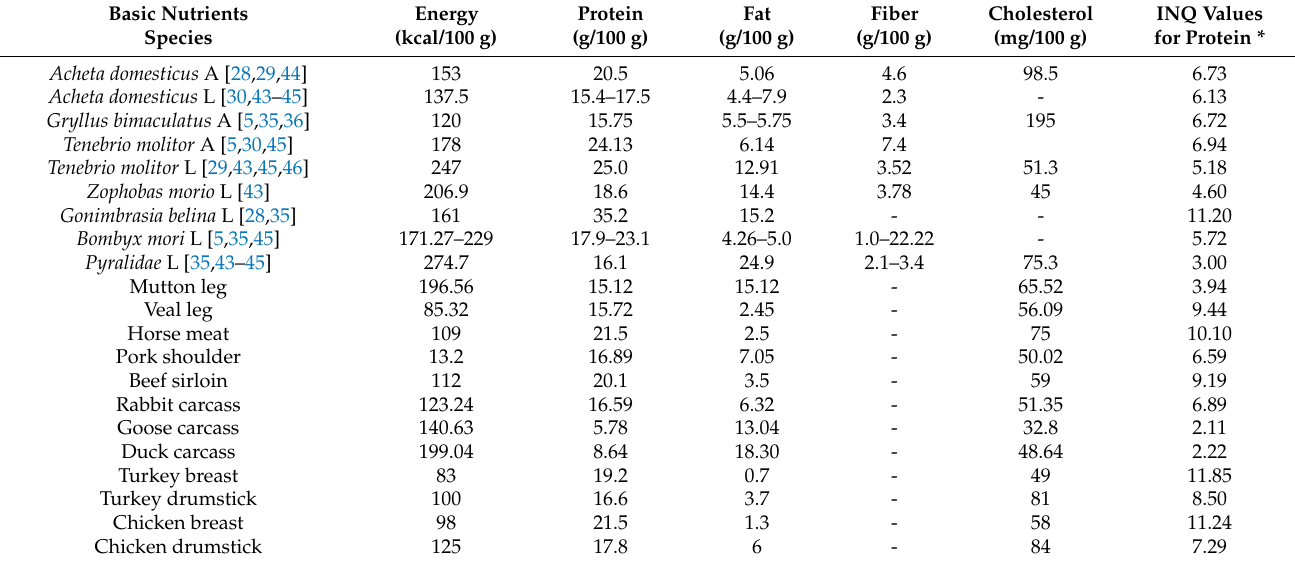
Table 2. The basic nutrients content of edible insects and meat expressed per 100 g of edible portion [5,28–30,35,36,43–46]. Basic Nutrients